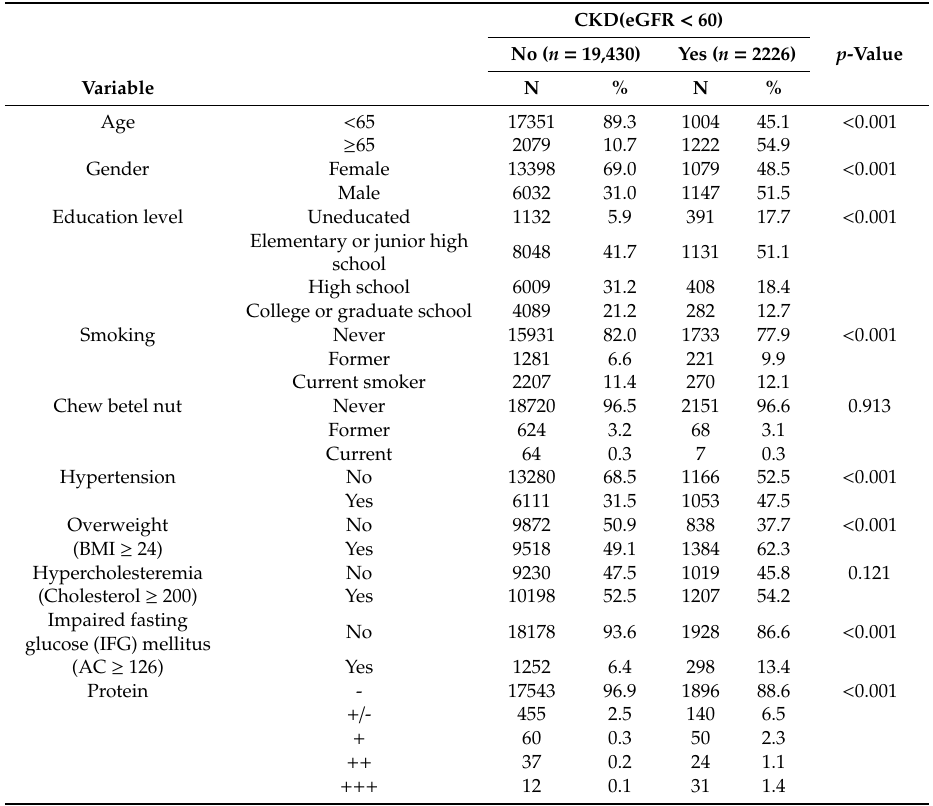
Table 2. Comparison between subjects with and without